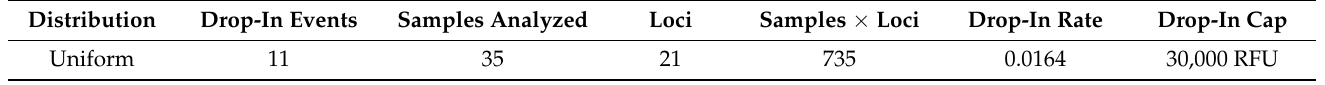
Table 2. STRmix TM drop-in data/parameters.